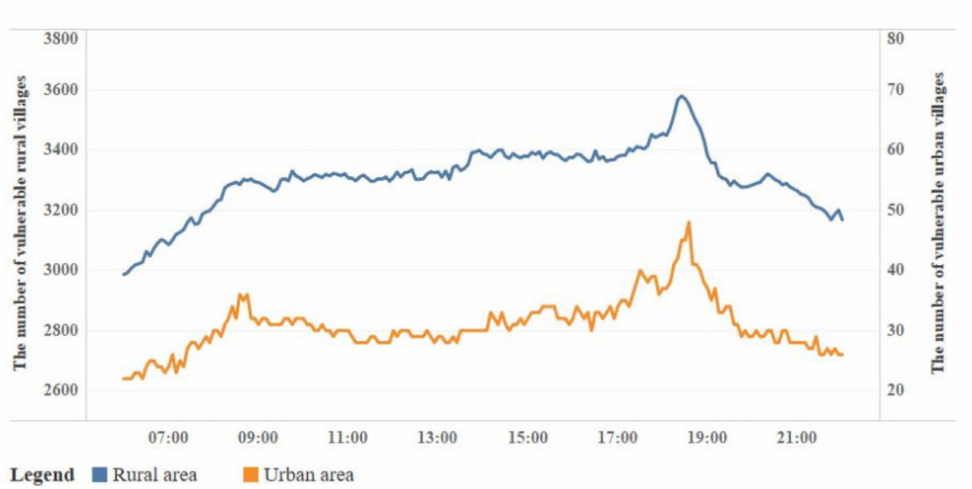
Figure 5. Number of vulnerable areas of EMS in urban and rural areas based on the real road tra ffi c speed in five-minute units. The number of vulnerable areas is marked as an orange line for urban areas and as a blue line for rural areas. The time slots when the number of vulnerable areas reach a peak during afternoon rush hour (17:00–20:00). The highest is 6:35 p.m. (48 villages) in urban areas, and 6:25 p.m. (3570 villages) in rural areas.